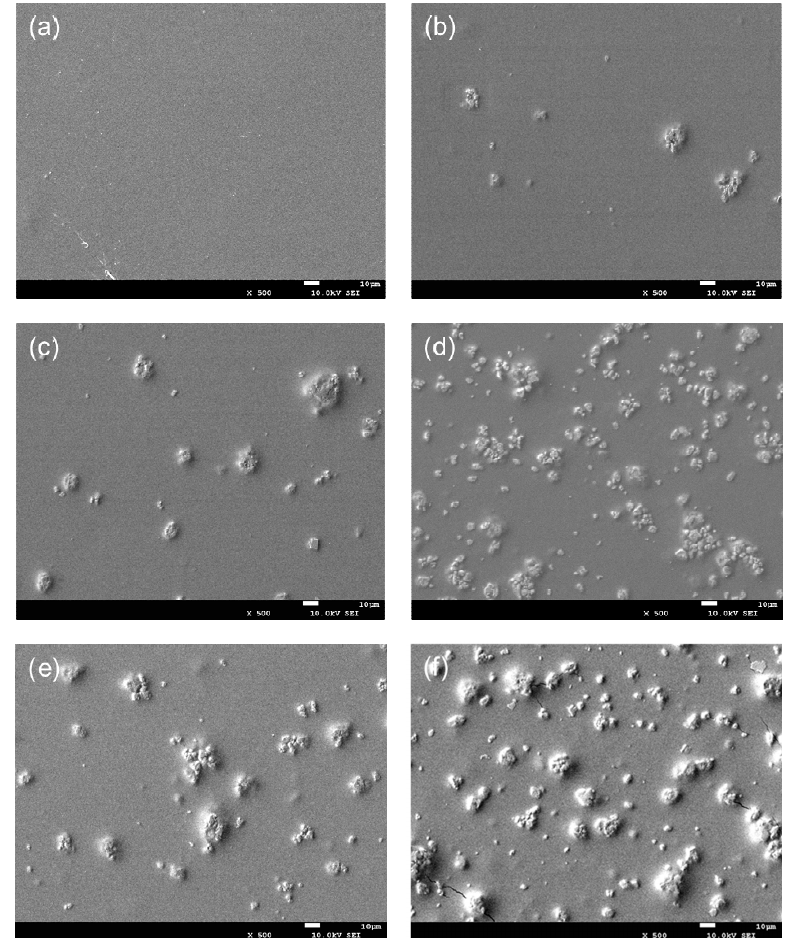
Figure 3. SEM images of chitosan-based coating film with TiO 2 nanoparticles ( a ) 0; ( b ) 0.01%; ( c ) 0.03%; ( d ) 0.05%; ( e ) 0.07%; ( f ) 0.09%.